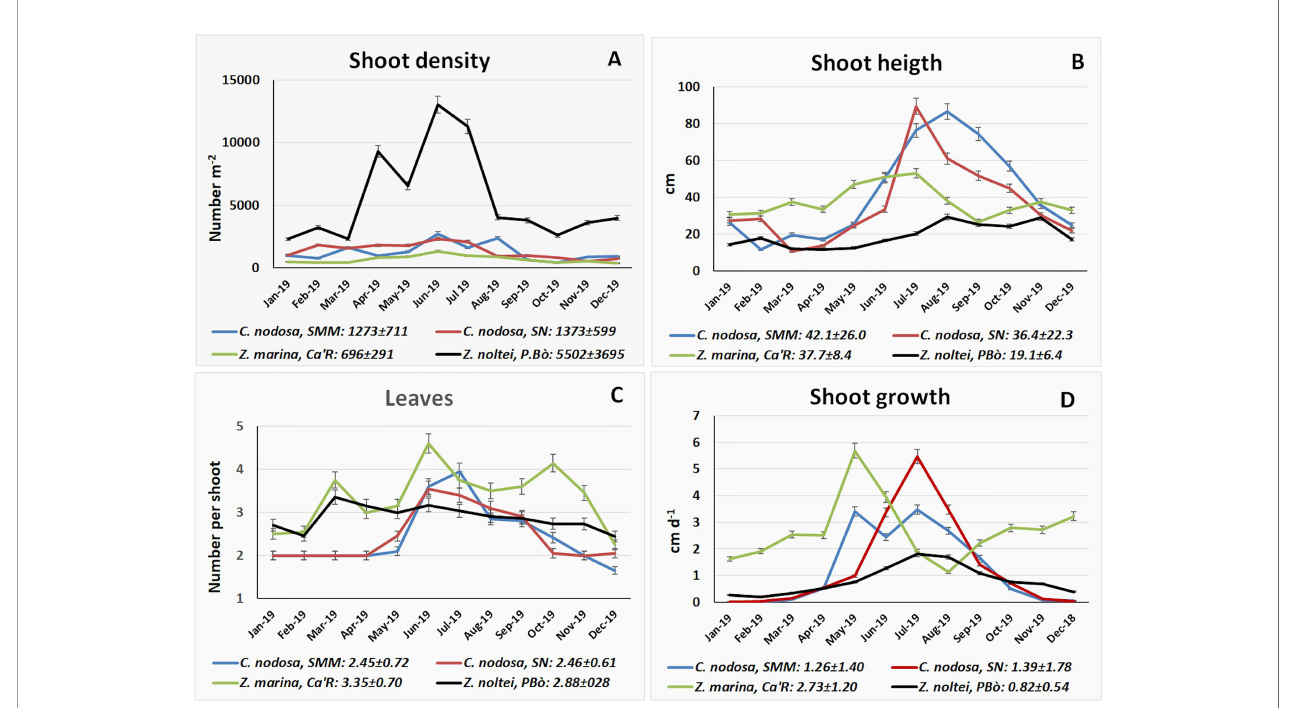
FIGURE 4 | (A) Shoot density, (B) shoot height, (C) leaf number, and (D) shoot growth of aquatic angiosperms monthly for 1